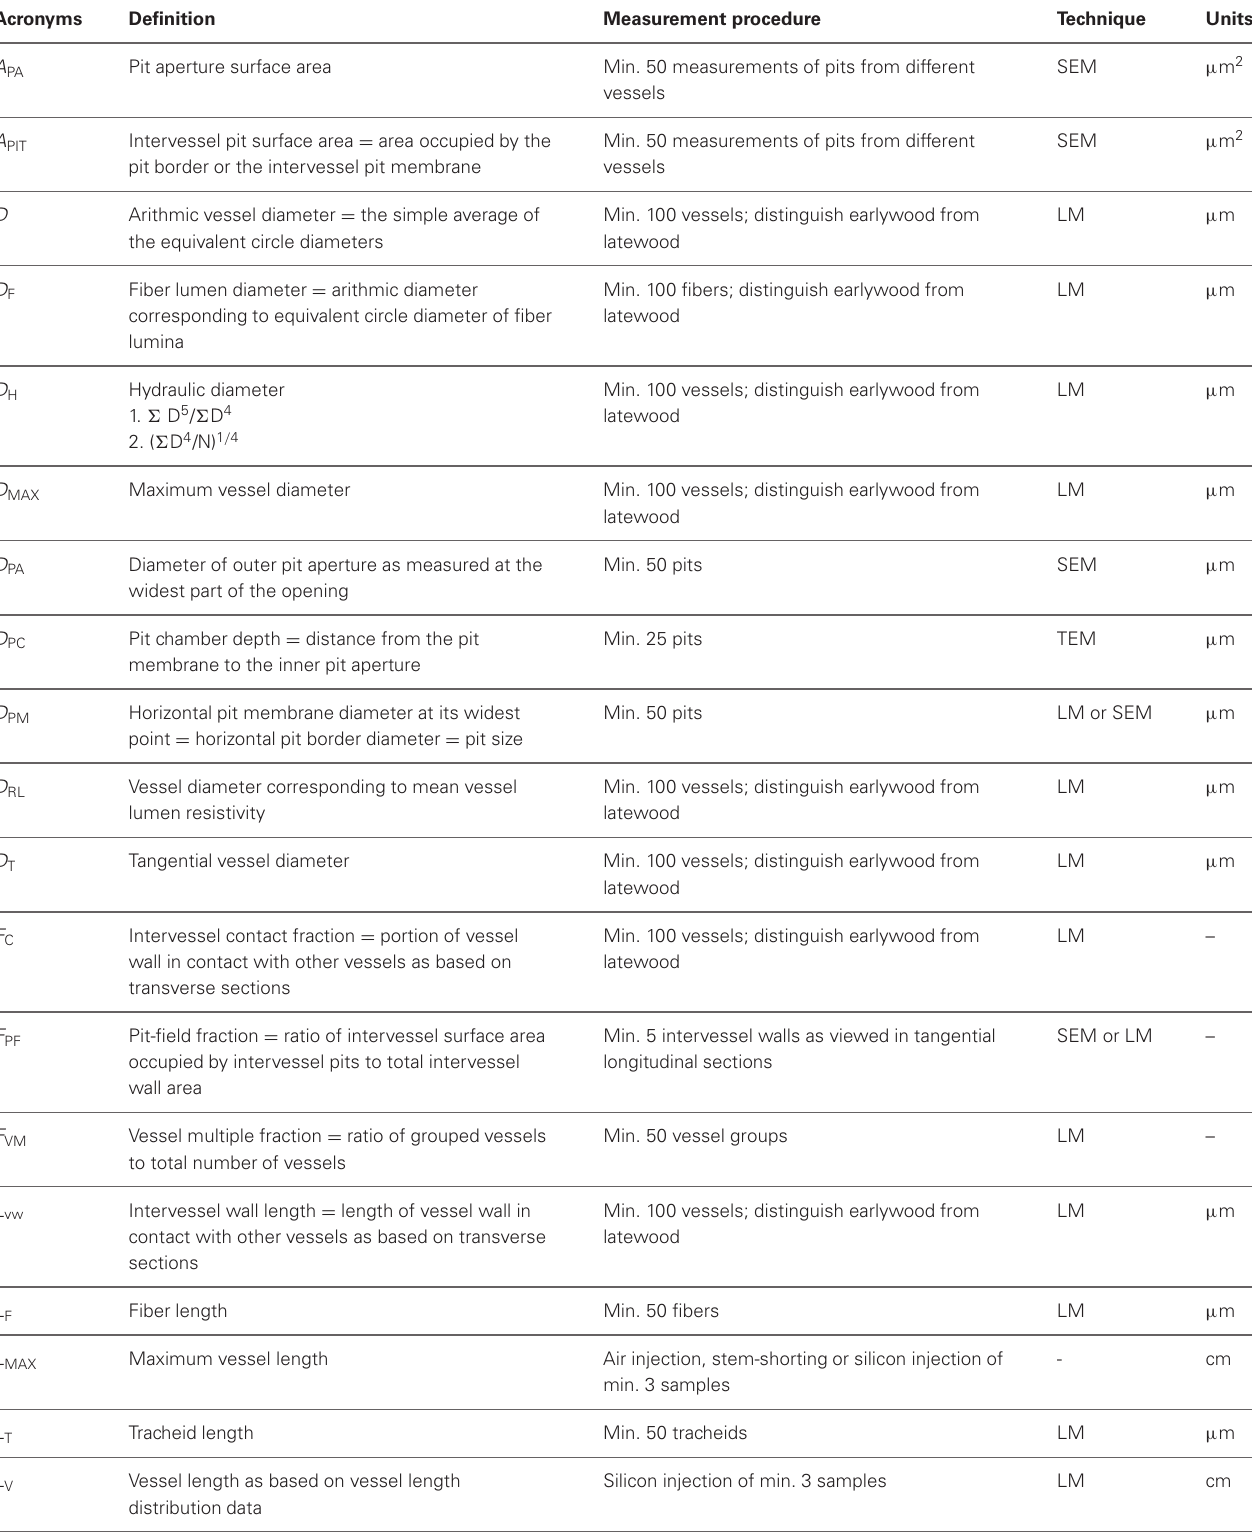
Table 1 | Overview of quantitative, directly measurable conduit characters with reference to their acronym, definition, measurement procedure, microscope technique, and